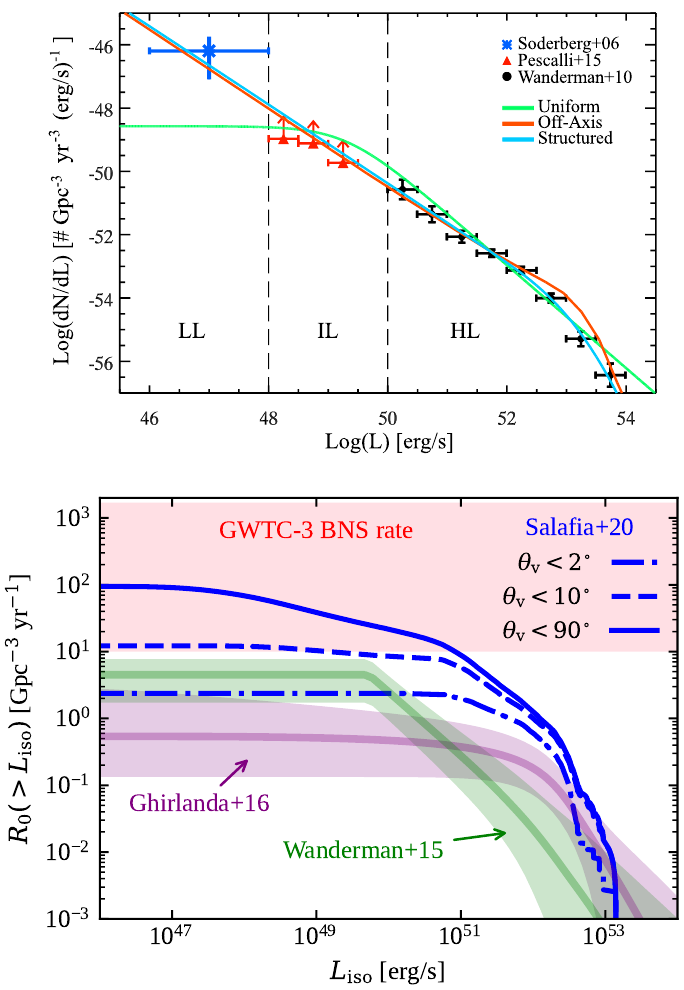
Figure 6. Top : luminosity function of Long GRBs as obtained by [210] (black symbols) extended to low luminosities by [206] (red and blue symbols). Models considering a uniform jet (only seen on-axis – green – or isotropically oriented – red) or a structured jet with a steep power law profile (cyan) are shown. The separation in low, intermediate, and high luminosity (LL, IL, HL) GRBs is indicated by the dashed vertical lines. Bottom : models of the (inverse cumulative) SGRB luminosity function. Models fitted to observed properties of short GRBs (detected at cosmological distances) are shown by the green [211] and purple [212] thick transparent lines and bands (medians and 90% credible regions). The luminosity function obtained by [114] by computing the jet structure from a semi- analytical calculation of the jet propagation and breakout is shown by the blue lines (contributions by jets observed in different intervals of viewing angle are shown), arbitrarily normalized to a local rate density R 0 = 100Gpc − 3 yr − 1 . The local BNS merger rate density constraint from [217], i.e., 10 ≤ R 0,BNS /Gpc 3 yr ≤ 1700, is shown by the pink shaded